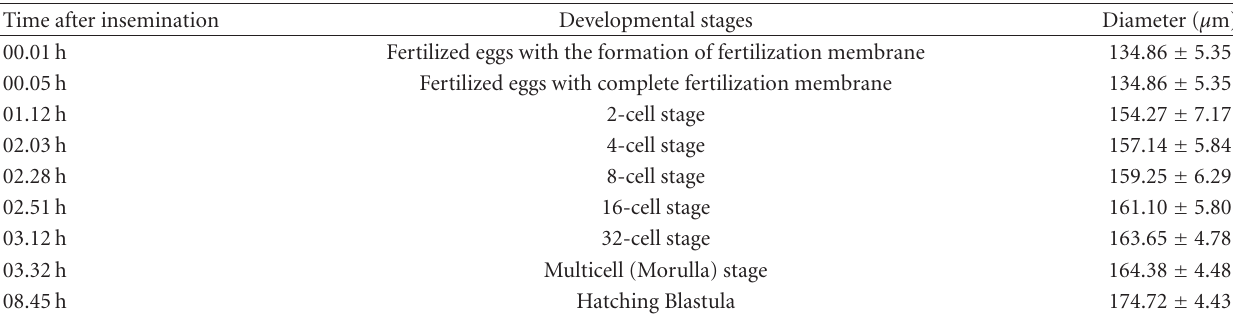
Table 1: Embryonic developmental events of S. sphaeroides . Three replicate fertilization experiments were conducted and for each developmental stage, 10 embryos from each replicate were used for the observation and measurement of